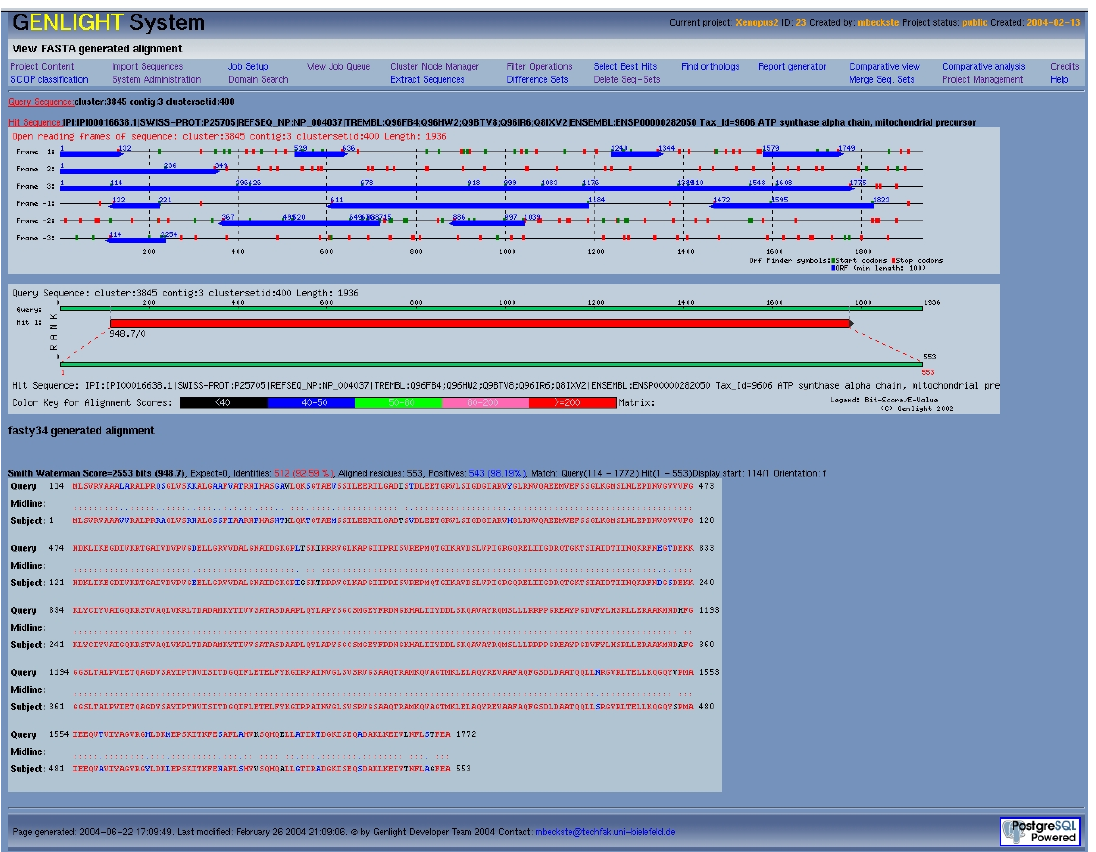
Figure 4: Screenshot showing graphical and colored textual representation of a FASTY align- ment. Open reading frames (top, blue boxes) and the matching region in query and target se- quences (bottom) are presented graphically. The corresponding textual alignment is shown at the bottom of the